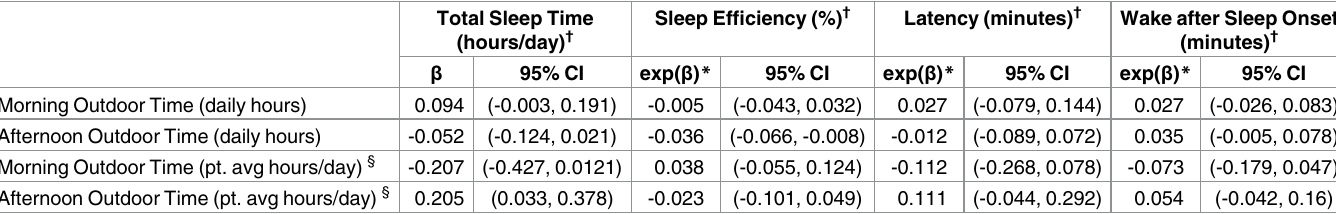
Table 3. The association between time of day outdoors and